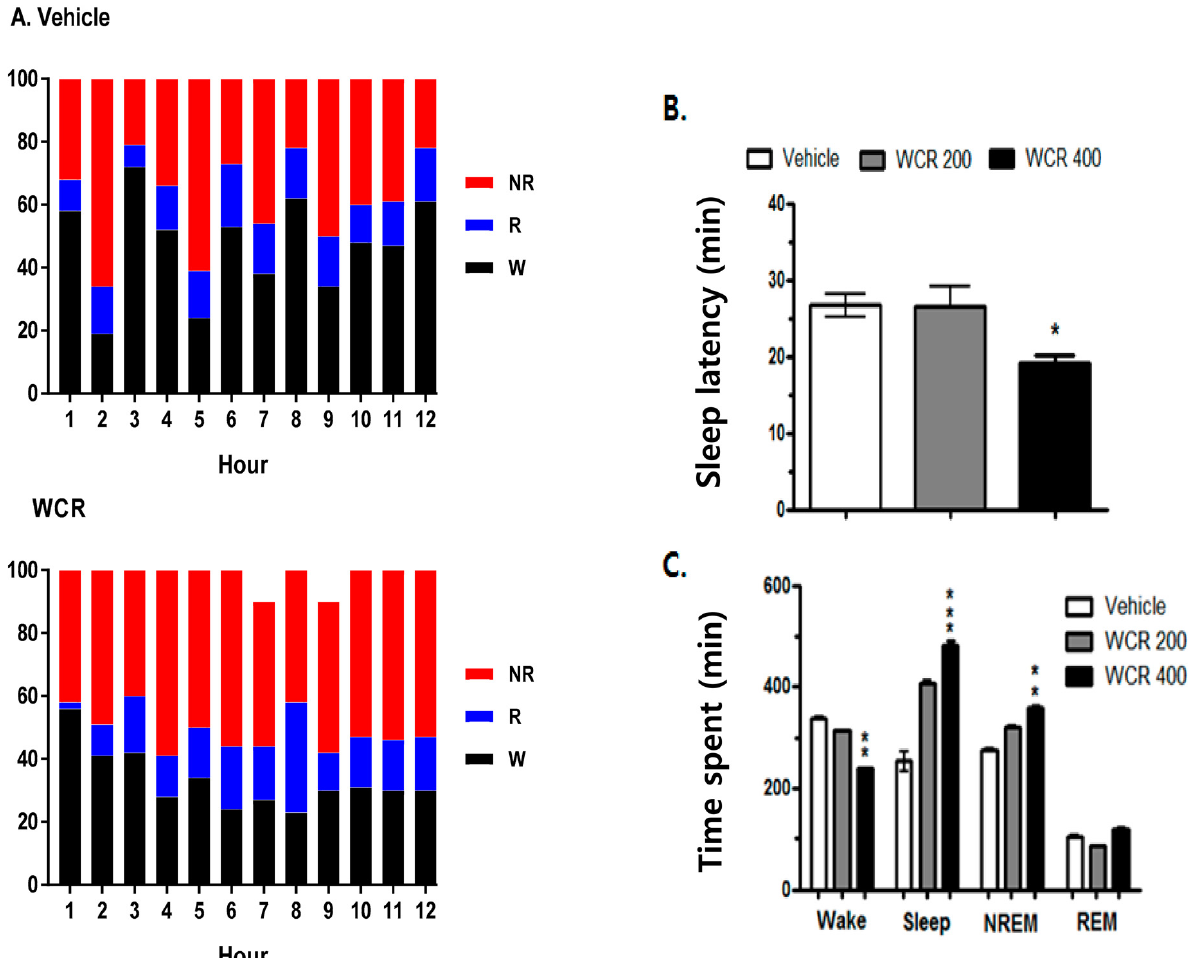
Figure 5. ( A ) Sleep–wake pattern in rats treated with the vehicle or WCR. ( B ) Effect of WCR on sleep latency. ( C ) Time spent in wake, total sleep, NREM sleep, and REM sleep after WCR administration. Each column represents the mean ± SEM. * p < 0.05, ** p < 0.01, *** p < 0.001, significantly different compared with the vehicle group. ANOVA followed by Tukey’s test. The CON group: treatment with the vehicle; the WCR groups: treatment with WCR (200 or 400